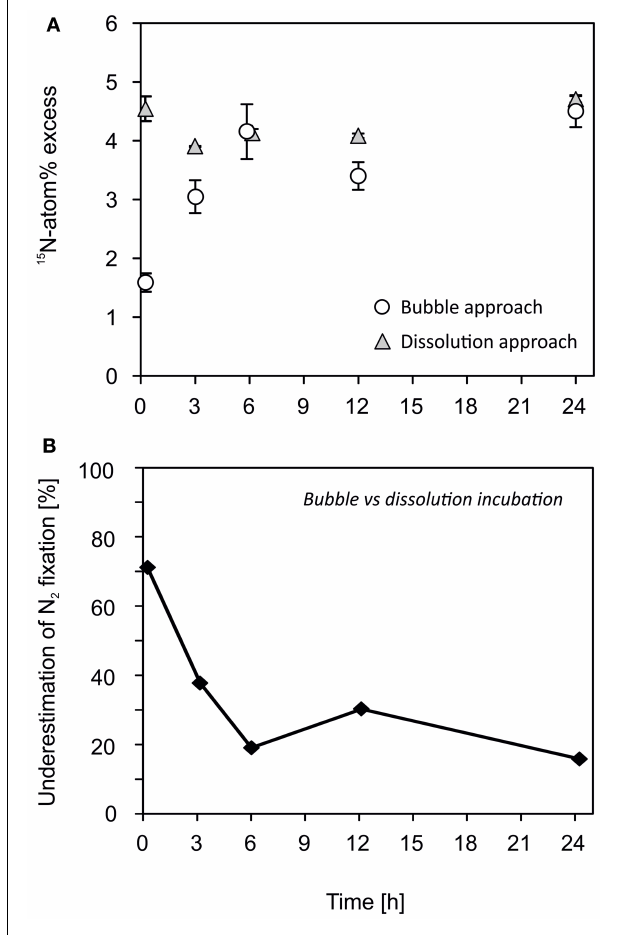
FIGURE 4 | A Nodularia spumigena culture was incubated following the former bubble-addition and the modified dissolution assay. (A) The dissolution of a 15 − 15 N 2 gas bubble was time-dependent. The 15 N-atom% increased over time if the 15 N-tracer was added as a bubble directly to the incubation volume (see also Mohr et al., 2010). The 15 N-atom% was more consistent as an aliquot of 15 − 15 N 2 -enriched water was added to the N. spumigena solution (dissolution approach). (B) Rates of N 2 fixation were underestimated by 16–71% when using the bubble approach compared to the dissolution